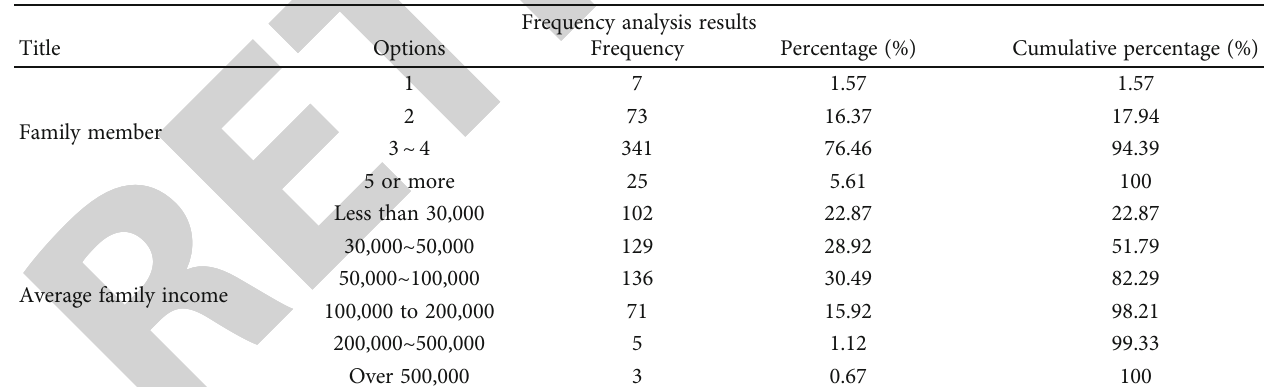
Table 2: Consumer household characteristics.